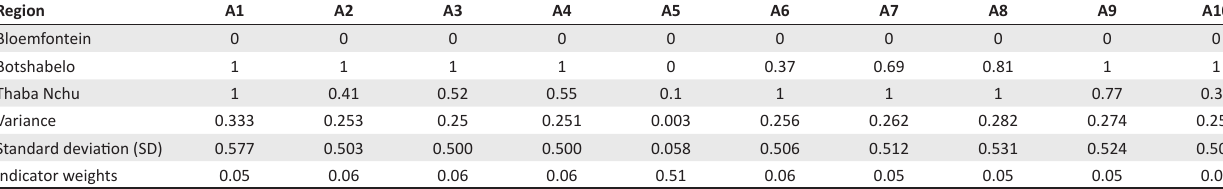
TABLE 5: Normalised indicator scores across three